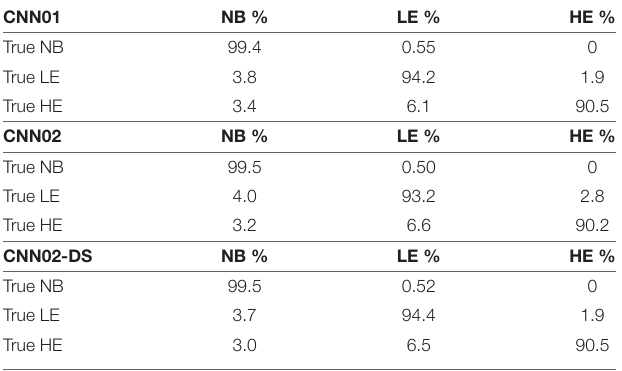
TABLE 3 | Classification accuracy comparison for CNN01 , CNN02 , and CNN02-DS on GPU or CPU.